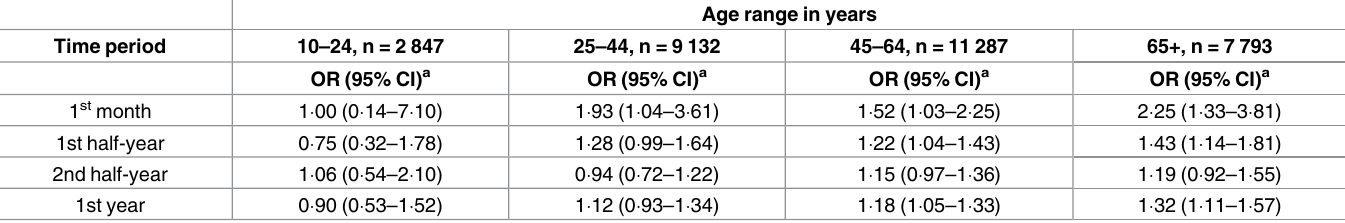
Age range in years